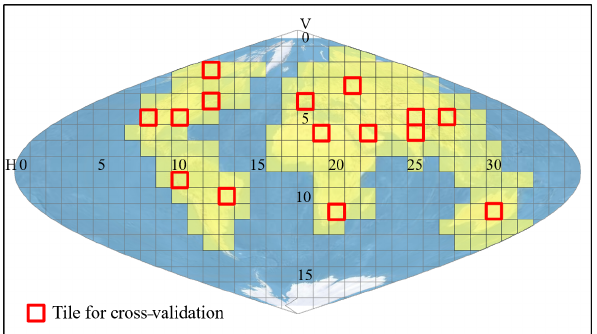
Figure 1. MODIS data tiles used in gap-filling and cross-validation